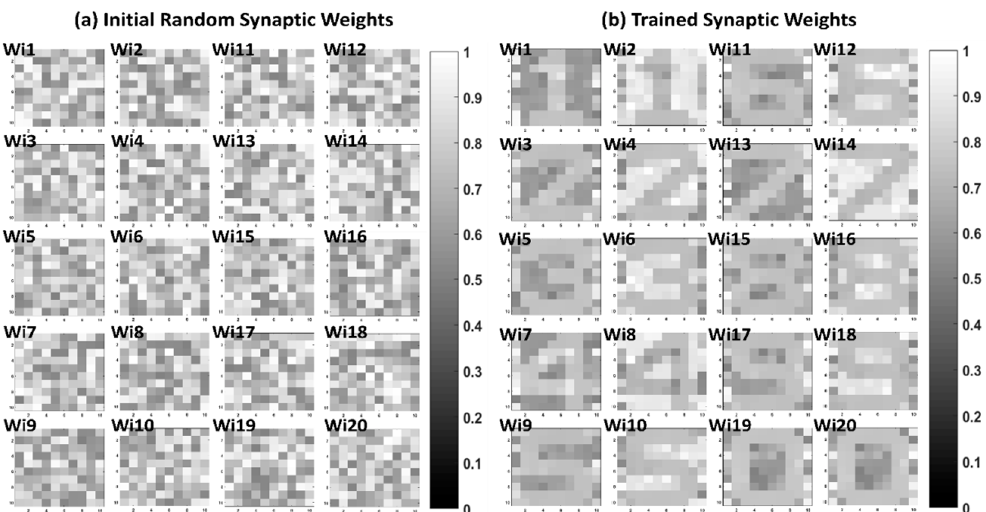
Figure 6. Synaptic weight matrix before and after guide training. A 100 × 20 memristor neural network is utilized for 10 × 10 digit image classification. Each output neuron has positive weights and negative weights. Wi1 represents the positive-column weights of output neuron 1, and Wi2 represents the negative-column weights of output neuron 1. The 100 memristor synapses of 20 columns are shown in the 10 × 10 2D images. ( a ) Initial random synaptic weights. ( b ) Trained synaptic weights after guide training. Trained synaptic weights are trained according to the predefined learning pattern. Table 5. Average accuracy of inference test of 10 × 10 digit image classification.